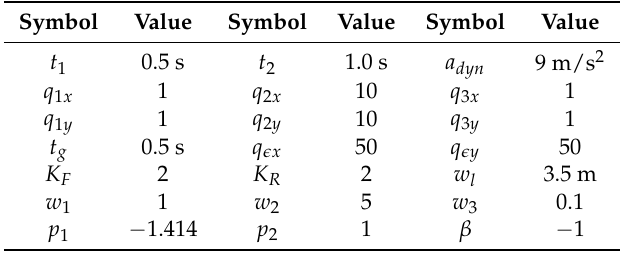
Table 2. Predefined Simulation